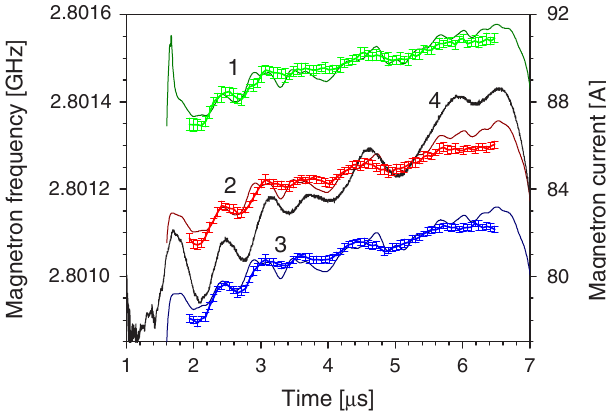
tor, and 10—movable